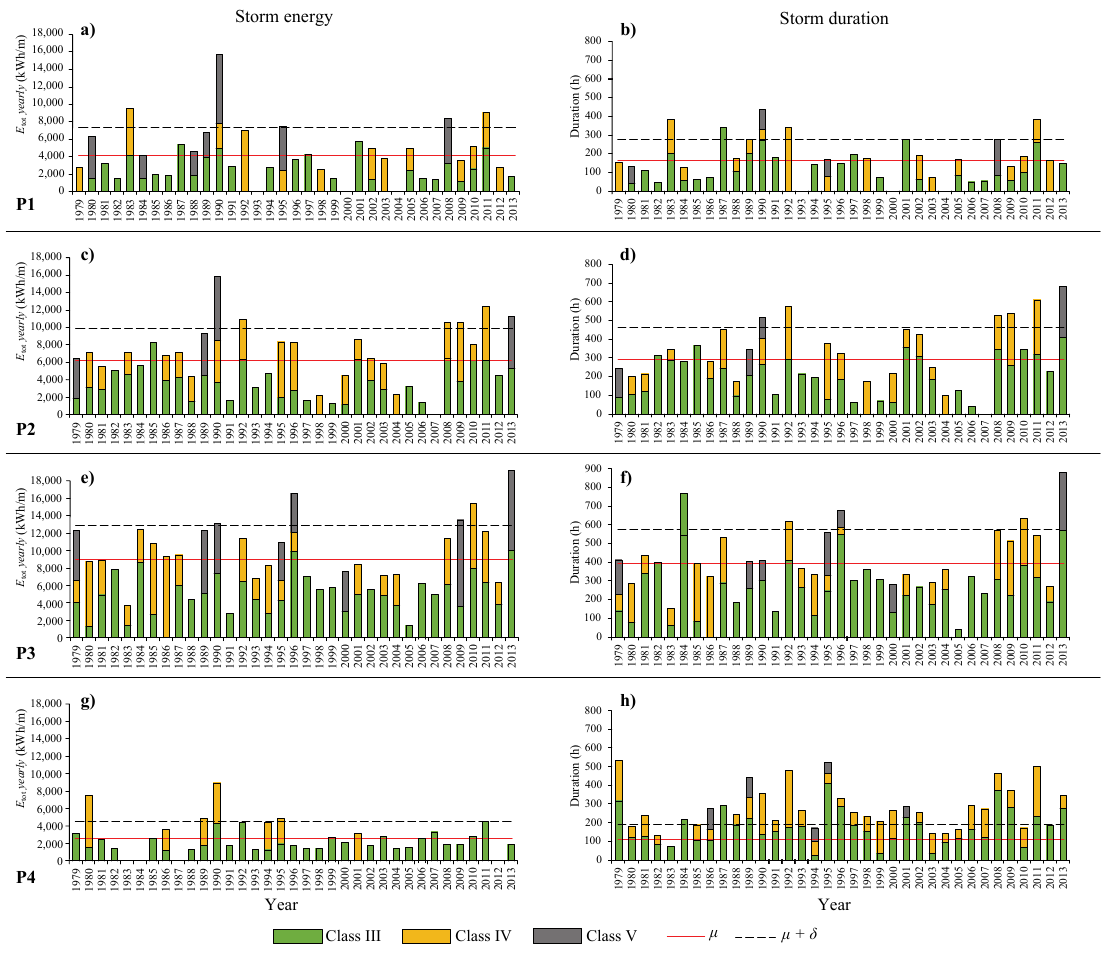
Figure 9. In the left column: the total energy of storms per year for Classes III, IV, and V. At ( a ) Point P1, ( c ) Point P2, ( e ) Point P3, and ( g ) Point P4. In the right column: the corresponding durations of storms ( b ) Point P1, ( d ) Point P2, ( f ) Point P3, and ( h ) Point P4. Red and dashed lines respectively represent the average value ( µ ) and the average plus one standard deviation ( µ + σ